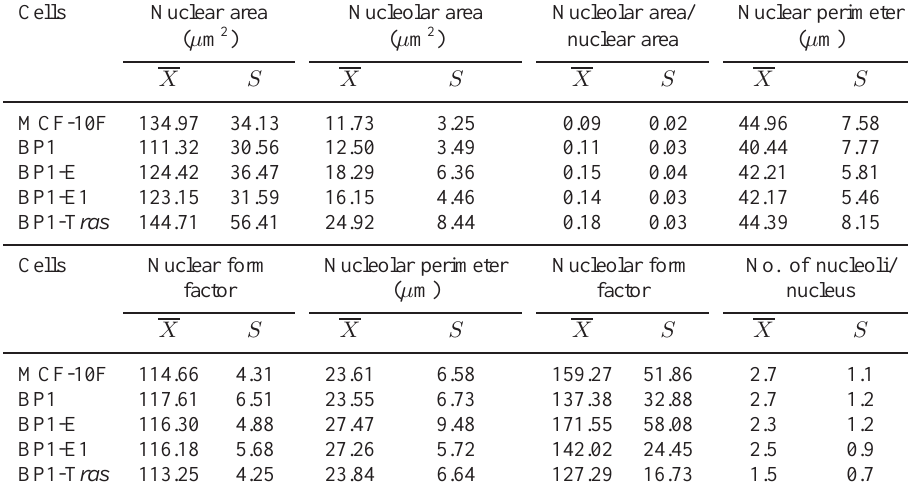
Table 1 Nuclear parameters in human breast epithelial cells transformed by benzo[a]pyrene and transfected with the c-Ha- ras oncogene ( n = 100)